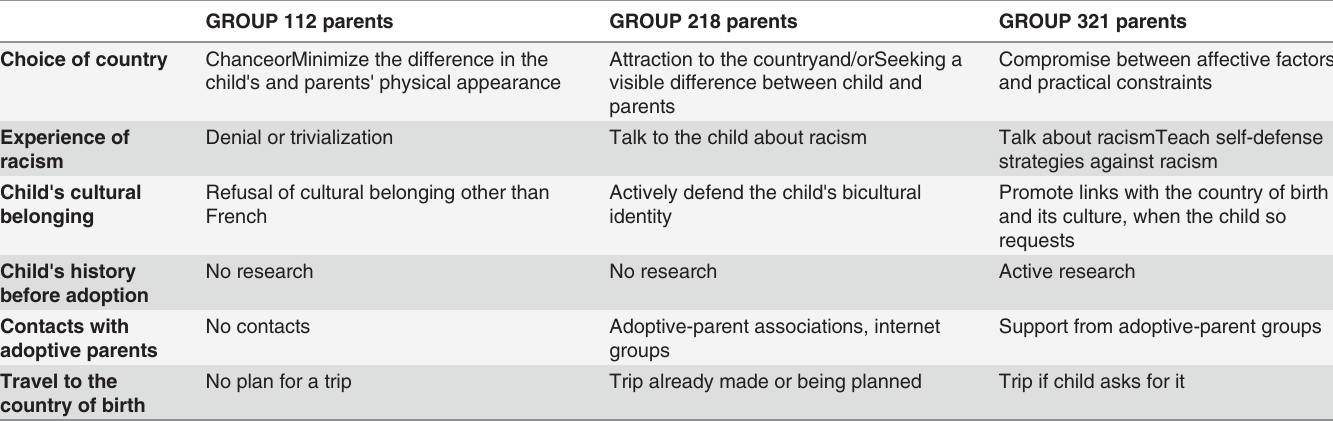
Table 1. Themes found in the three groups.